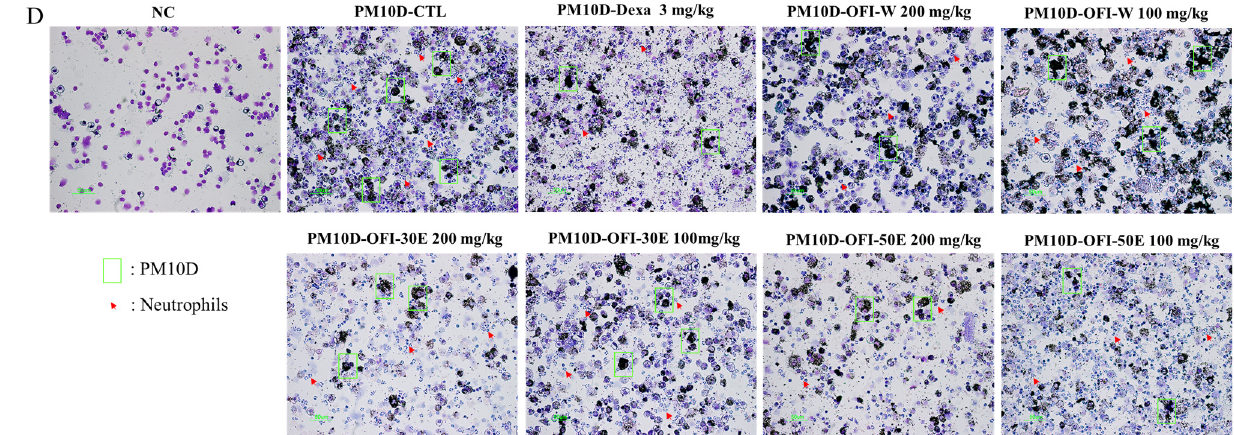
Figure 2. Effects of water and ethanolic extracts of OFI on airway immune cell numbers in in a PM10D-induced airway inflammation model. ( A ) Total lung cell numbers, ( B ) total bronchoalveolar lavage fluid (BALF) cell numbers, ( C ) neutrophils numbers in BALF cytospin, and ( D ) photomicrograph of BALF cytospins (magnification: 200×). NC: BALB/c normal control group; CTL: PM10D-induced control group; Dexa: 3 mg/kg dexamethasone-treated PM10D-induced group; OFI-W 100 and 200: PM10D-induced group treated with 100 and 200 mg/kg OFI-water extract, respectively; OFI-30E 100 and 200: PM10D-induced group treated with 100 and 200 mg/kg OFI-30% ethanol extract, respectively; OFI-50E 100 and 200: PM10D-induced group treated with 100 and 200 mg/kg OFI-50% ethanol extract, respectively. Data are expressed as means ± standard error of the mean (SEM), n = 8. ### p < 0.005 vs. NC; * p < 0.05, ** p < 0.01, and *** p < 0.005 vs. CTL. Table 1. Effects of water and ethanolic extracts of OFI on airway immune cell number and neutrophilic airway inflammation in a PM10-induced airway inflammation model.